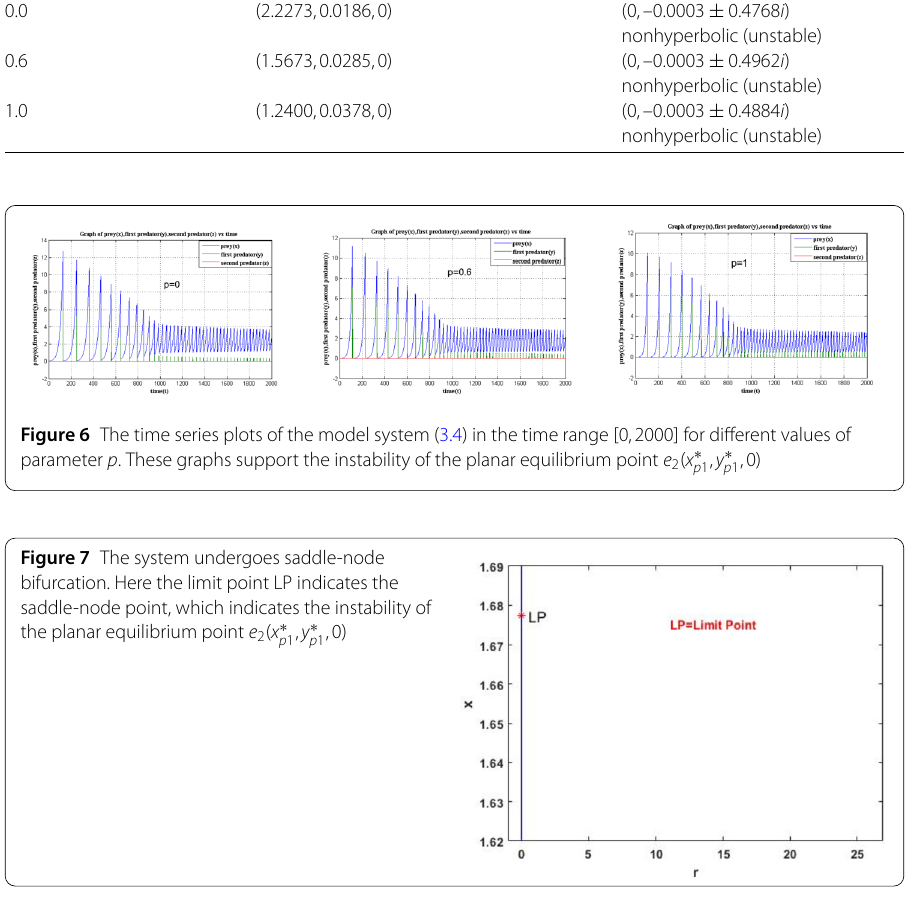
Table 6 The nature of the planar equilibrium point for different values of the parameter p p Equilibrium point Eigenvalues of Jacobi matrix Nature